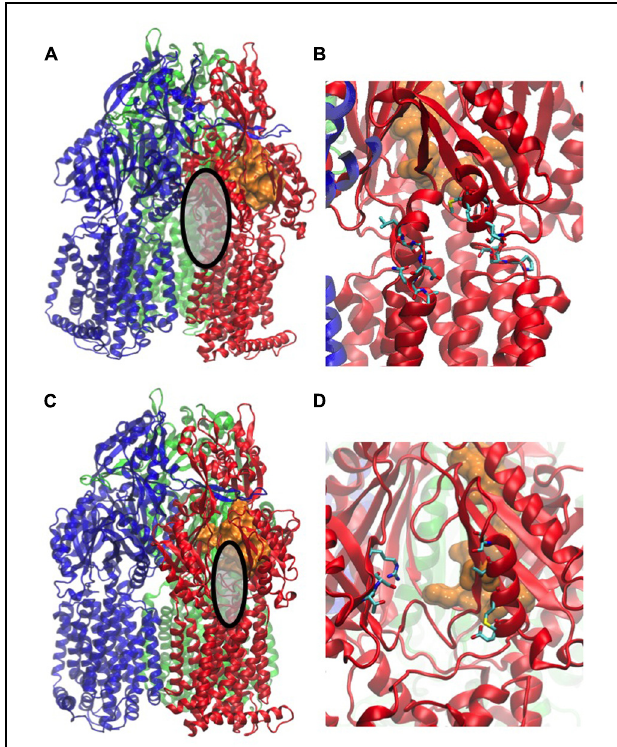
FIGURE 3 | Main entrances of paths for compounds. The structure used in the figure corresponds to the PDB code 2V50 (Sennhauser et al., 2009). MexB monomers are colored in blue, red, and green, respectively. The distal binding pocket in the T monomer is represented as orange surface. The entrance of the vestibule is highlighted as gray surface in (A) and shown with the atomic details (in licorice colored by atom type) in (B) , that of the cleft as gray surface in (C) , and its atomic details in (D) . All the atomic-level figures were rendered using VMD (Humphrey et al.,